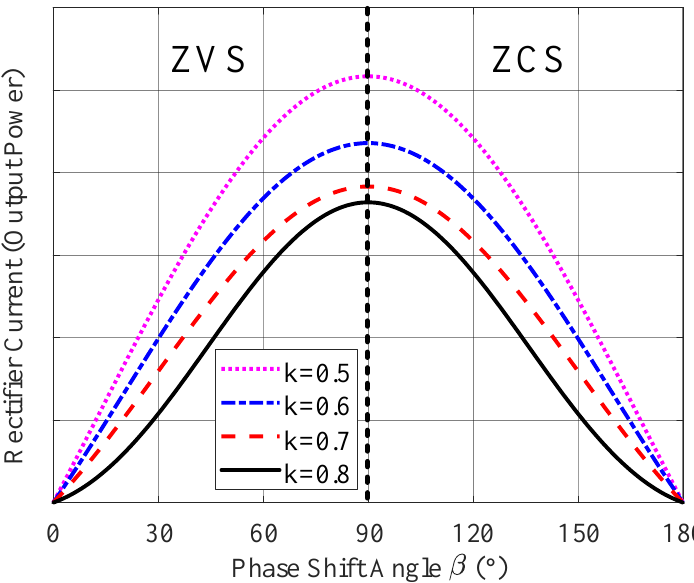
Figure 6. Variation of I REC or P out with β